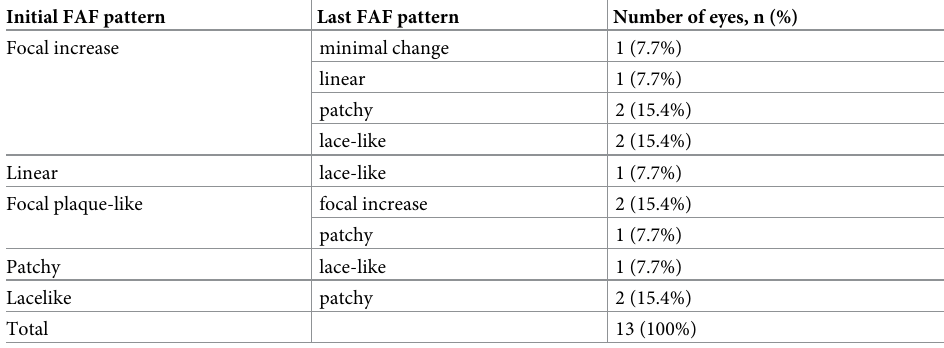
Table 3. Pattern alterations observed during follow-up.